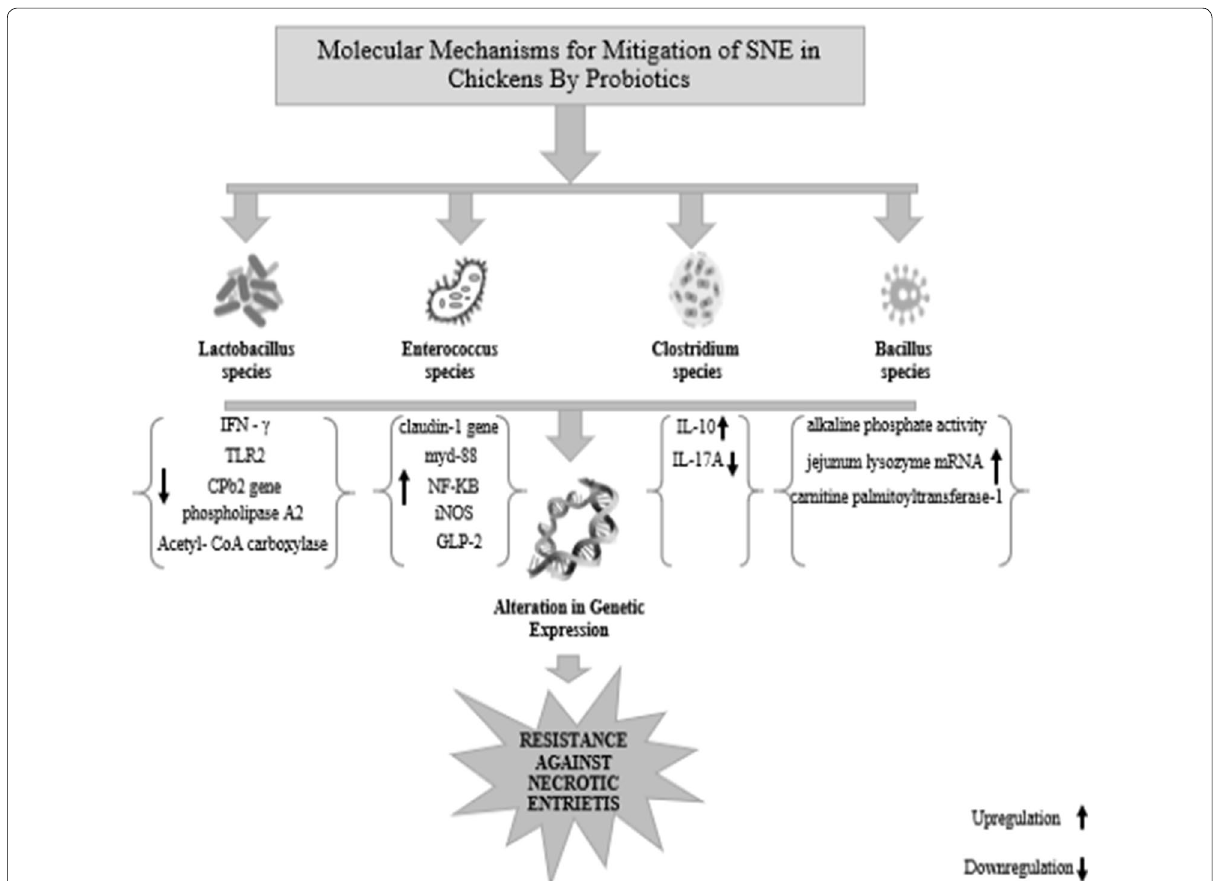
Fig. 2 Molecular mechanisms explaining the positive effects of probiotics against